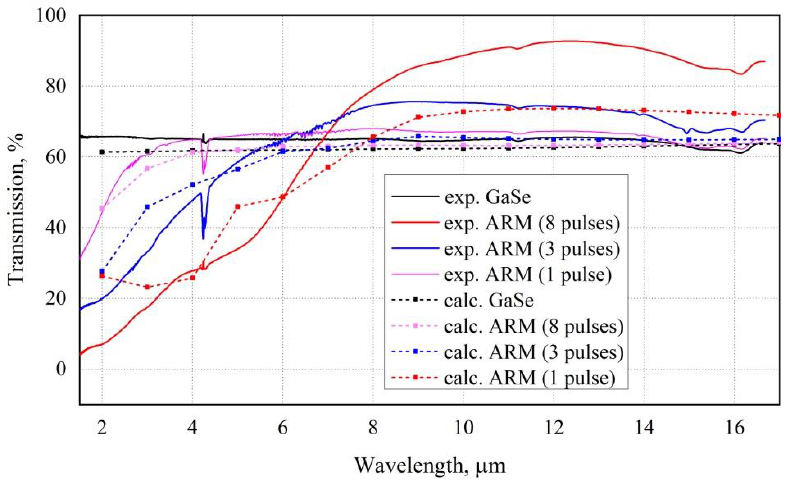
Figure 16. Transmittance spectra of crystal with modification on both sides: experimental data of the spectra of ARMs inscribed on both sides at E = 37.5 nJ and different pulse numbers (solid) and simulation (dashed with squares).